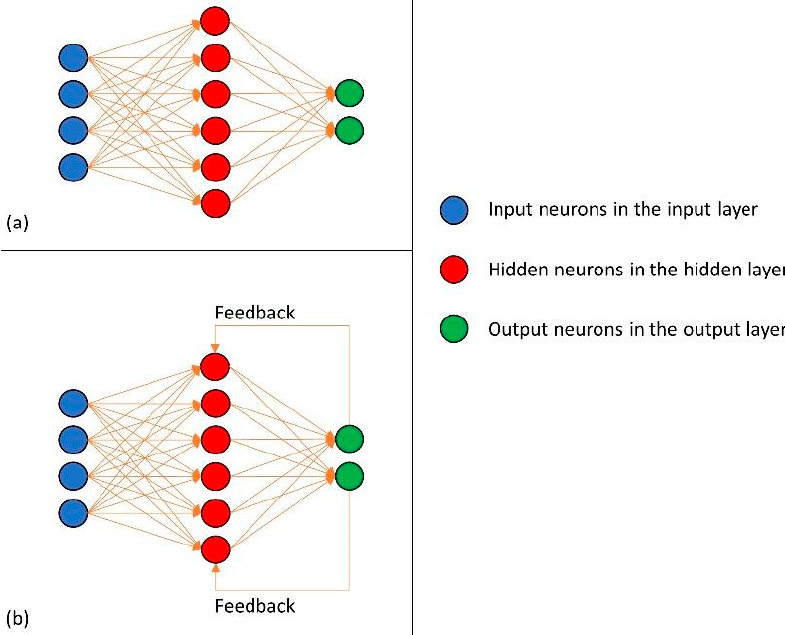
Figure 14. ( a ) Typical structure of FFNNs; ( b ) typical structure of